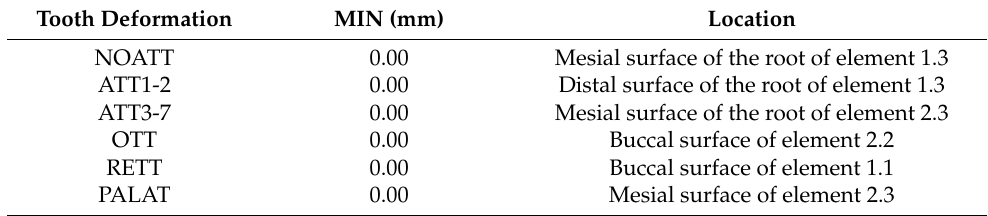
Table 4. Minimum tooth deformation and